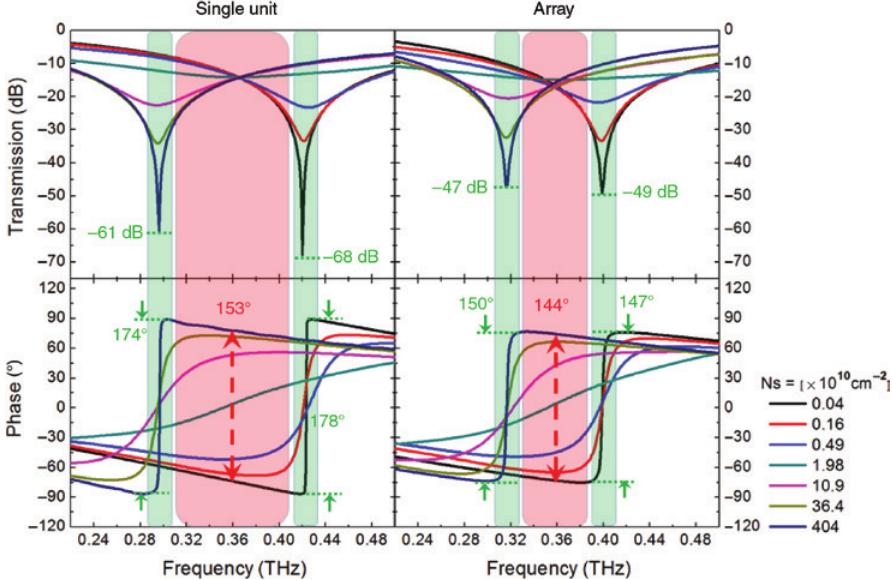
Figure 6: Simulation results of the transmission and phase spectra with different carrier densities for single unit and an